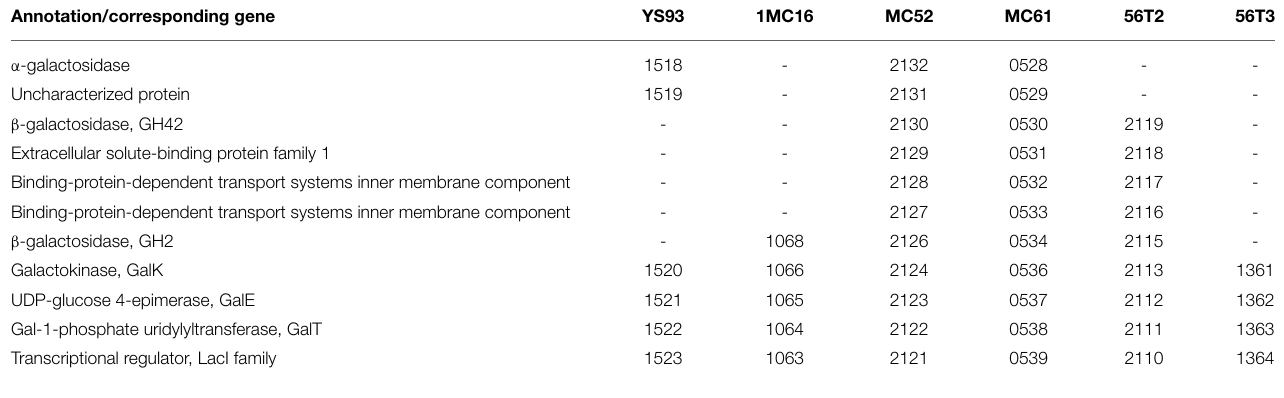
TABLE 10 | Galactose and galactoside metabolic